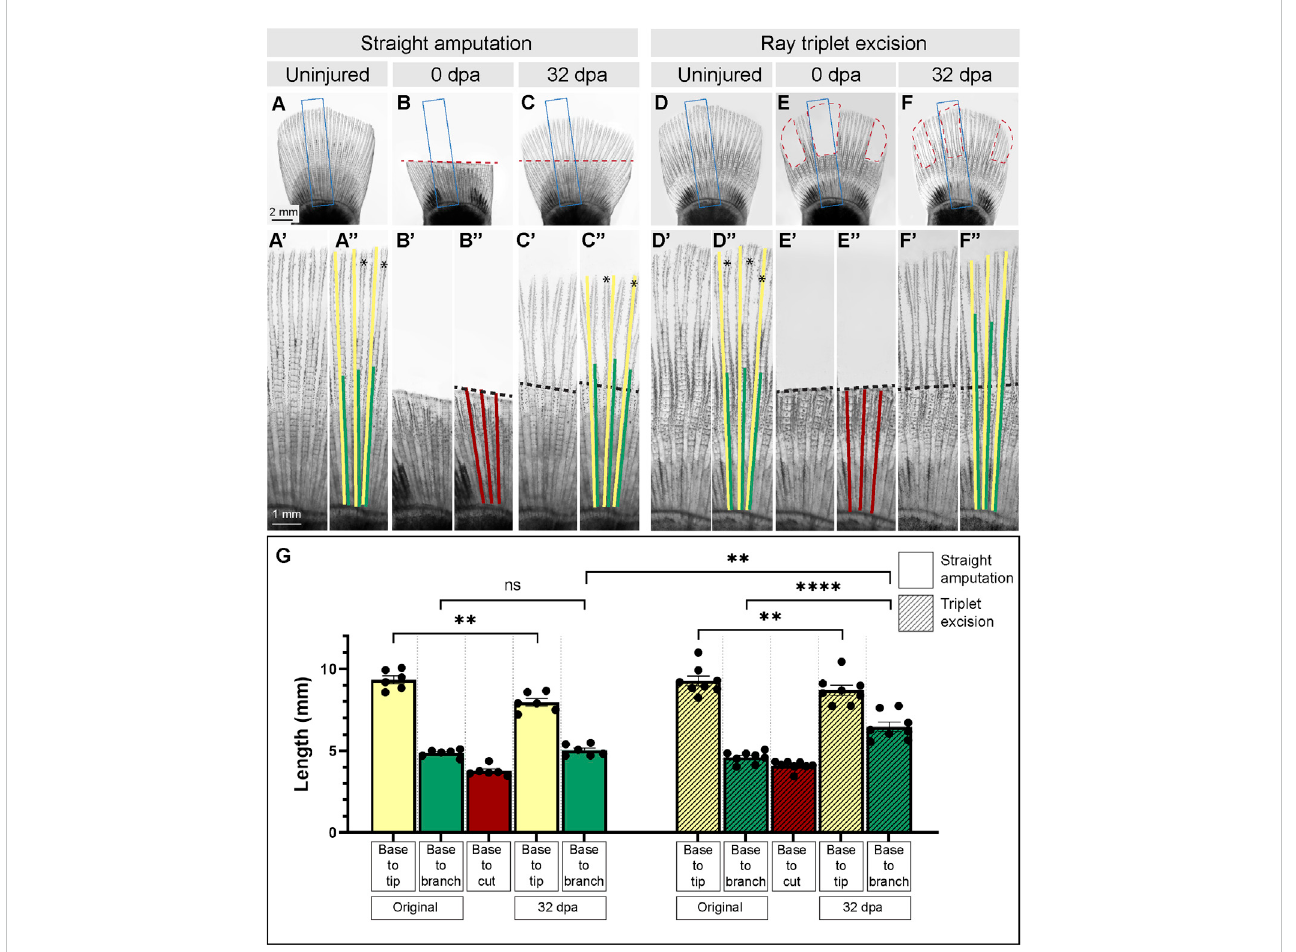
FIGURE 2 Morphometricanalysisofraysandtheirprimarybranchpointsinregenerated fi nsfollowingremovalofallorafewrays. (A – F) Liveimagingofplaty fi sh fi ns before amputation (uninjured), immediately after amputation (0 dpa) and during the terminal phase of regeneration (32 dpa), in two experiments that involve straight amputation or ray triplet excision, as labeled above the photographs. Blue frames encompass the area that is magni fi ed below the photo, and are labeledwiththesameletterwithaprimesymbol(A ″ ,B ″ ,C ″ ,E ″ ,F ″ ).Reddashedlinesdepictthesurgeryplane.Thecoloredlinesoverlapwithpartsofrays that were measured. Yellow lines correspond to the ray length from base to tip, the green lines depict the length from base to bifurcation point, the red lines demarcate the length from base to the cut. These parameters are plotted in the graph (G) for each amputation type. Black dashed lines indicate amputation planes, and asterisks shows secondary bifurcations, if present. Statistics: For straight amputation, N = 6; for ray triplet excision, N = 8; measurements per fi n represent average ofthree rays per fi sh; error bar, SEM;n.s., notsigni fi cant, p > 0.05;** p < 0.01; **** p < 0.0001; pairedtwo-tailed Student ’ st-testwithin each experiment; unpaired two-tailed Student ’ s t-test between